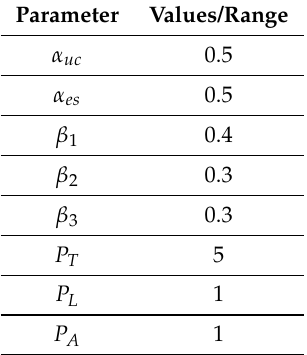
Table 4. Parameter settings for the optimization